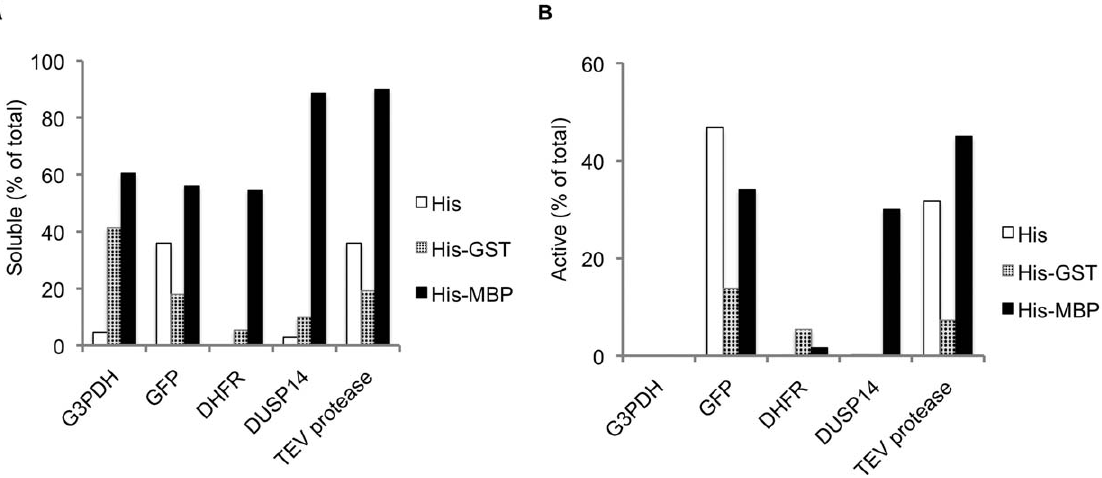
Figure 2. Yield and activity of soluble fusion proteins after refolding. The yield of soluble fusion protein (A) and active passenger protein (B) was calculated and expressed as a percentage of the total amount of protein added to the refolding reactions.